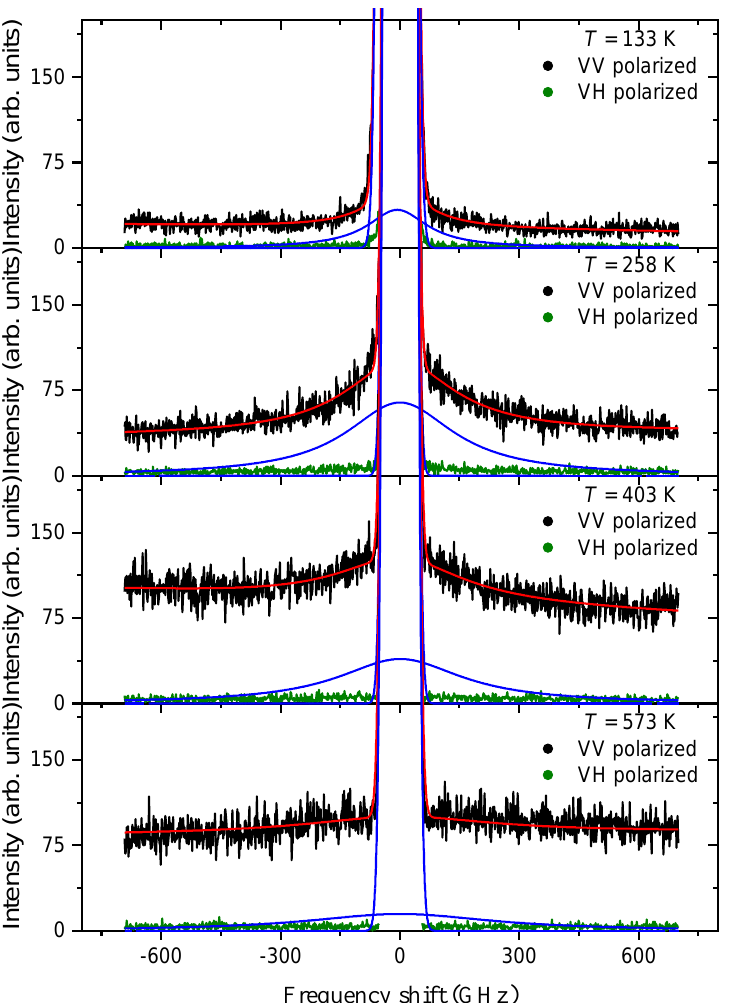
Figure 4. Polarized spectra of Brillouin light scattering in PMN (FSR = 800 GHz) and examples of their processing at different temperatures. The solid red line is the result of calculations using expression (4); fitting was carried out for the VV polarized spectra. Blue line is the contour of the QELS obtained as a result of data fitting (see text).